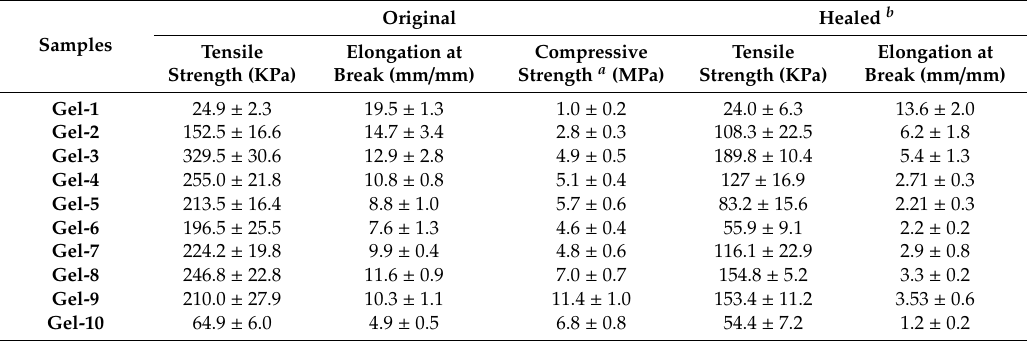
Figure 7. Tensile stress-strain curves ( a,b ) and compressive stress-strain curves ( c,d ) of P(AAc-co-Am) / PVA double network hydrogels: ( a,c ) hydrogels with various Am / AAc ratios; ( b,d ) hydrogels with various Fe 3 + concentrations. Table 2. Mechanical properties of P(AAc- co -Am) / PVA double network hydrogels.